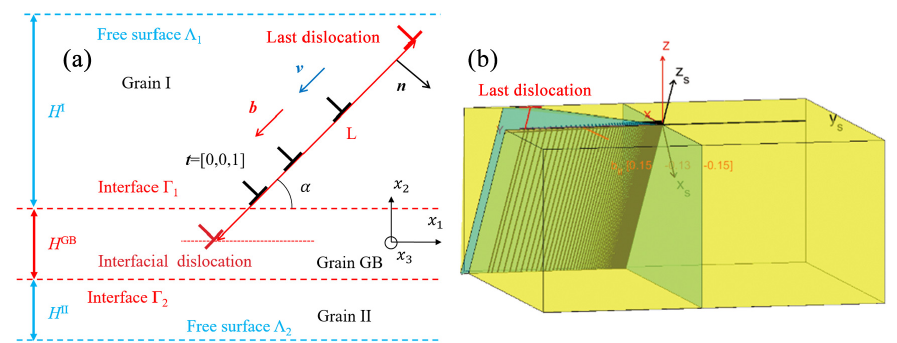
Figure 7. ( a ) α -inclined single-ended discrete dislocation pile-up in a slip plane of unit normal n for N equilibrated edge dislocations with Burgers vector b and line vector t in a heterogeneous anisotropic bi-crystalline